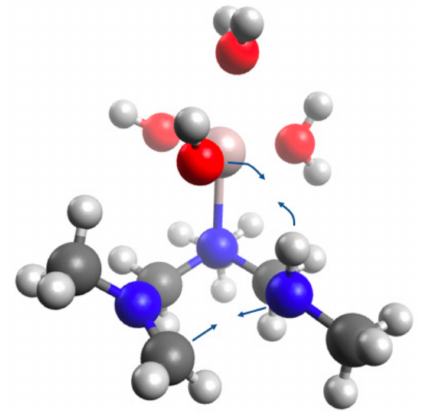
Figure 5. Key rate determining transition-state of aluminium catalysed process with arrows indicated displacement vectors of atoms. Cyclization is accompanied with deprotonation by hydroxide at secondary amine.